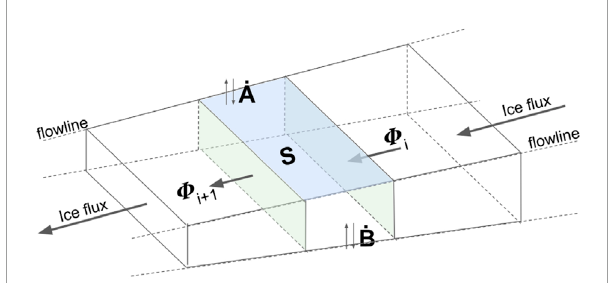
FIGURE 3 Ice tongue section depicting the main components of Eq. 4 . Basal mass balance ( ̇ B ) , surface mass balance ( ̇ A ) , ice flux at the gate i (Φ i ) and i + 1 (Φ i +1 ) and the area between gates S . For clarity, the surface area has been coloured pale blue and the gate areas have been coloured pale